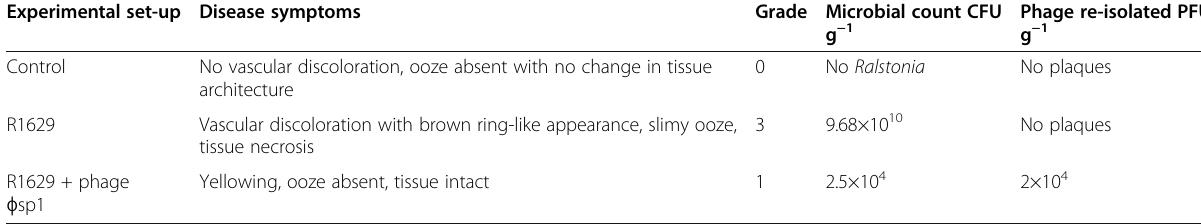
Table 3 Phage ɸ sp1 biocontrol efficacy in potato tuber slice bioassay using Ralstonia solanacearum strain 1629 (R 1629) Experimental set-up Disease symptoms